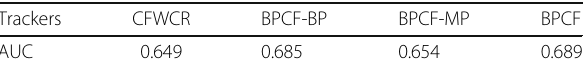
Table 2 Baseline comparisons when using background perception (BPCF-BP) and model update (BPCF-MU) separately and jointly (BPCF). We report the AUC score on the